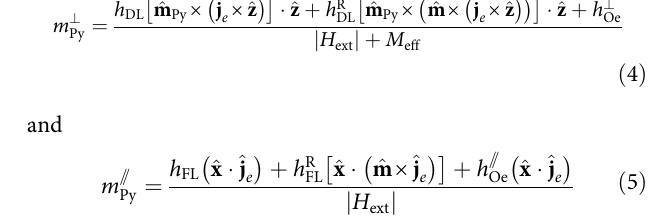
H ϕ = 0°). No dependence on ^ m is observed. The measurement ext ( and Δψ odd of the test sample, where we de fi ne polar polar . The fi rst superscript in ψ þ þ denotes the sign of ^ m and polar (cid:1) (cid:3) (cid:1) ¼ 25 : 5 cos π ϕ ¼ 6 : 3 sin π ϕ and Δψ odd 180 180 polar polar and Δψ odd polar